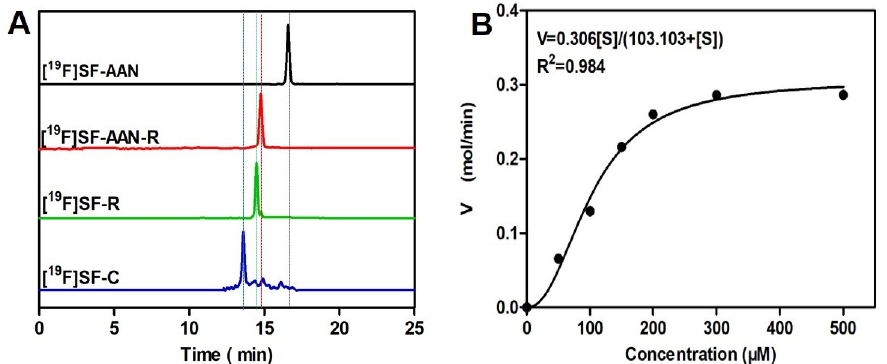
Figure 2. Characterization of reduction and legumain-induced condensation of nonradioactive probe [ 19 F] SF-AAN in vitro. ( A ) HPLC traces of [ 19 F] SF-AAN alone (black), [ 19 F] SF-AAN-R (red), [ 19 F] SF-R (green) and [ 19 F] SF-C (blue) obtained from [ 19 F] SF-AAN (50 μ M) treated with TCEP for 30 min (1 mM) and legumain working buffer at 37 °C for 1 h (100 μ L, 1 μ g/mL legumain, 20 mM citric acid, 60 mM disodium phosphate, 1 mM EDTA, 1 mM DTT, pH = 5.5). ( B ) Enzyme kinetics of the probe [ 19 F] SF-AAN towards legumain.